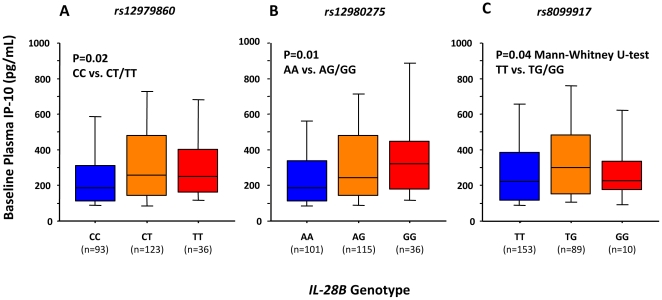
Tenth, 25th, 50th, 75th, and 90th percentiles of pretreatment IP-10 in relation to IL28B variants.